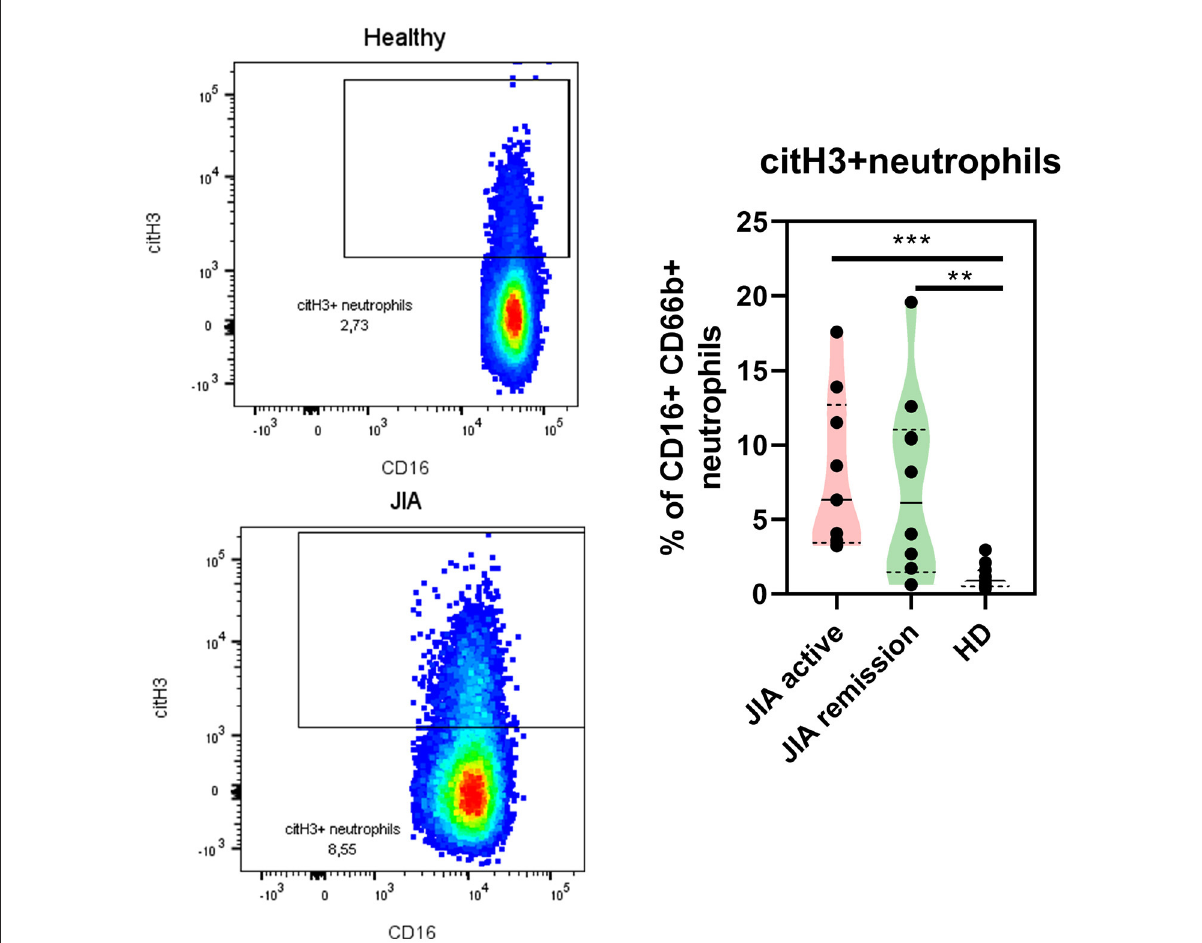
FIGURE4 NETting neutrophils in JIA patients. Representative dot plots of the citH3 + neutrophil population (Lin-CD66b + CD16 + ) and quantification of citH3 + neutrophils in JIA active ( n = 9), JIA remission ( n = 10), and healthy donors ( n = 11) using flow cytometry. Values are standardized and expressed as median values. Statistical analyses were performed using unpaired t -tests. Values of p < 0.05 (*), p < 0.01 (**), p < 0.001 (***), and p < 0.0001 (****) were considered statistically